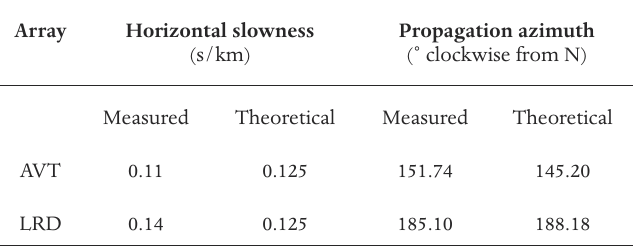
Table 1. Comparisons between the propagation parameters of the first P-wave pulse obtained from array analyses and those predicted from the Li et al. [2007] velocity